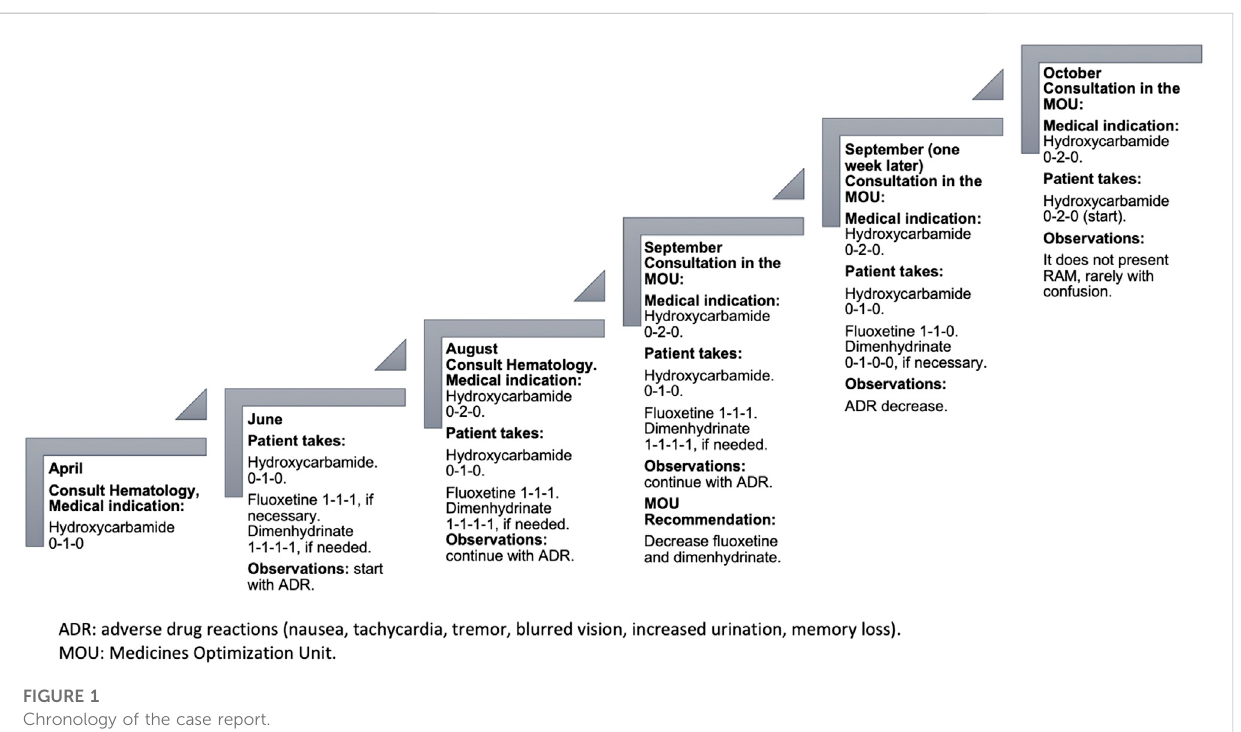
FIGURE 1 Chronology of the case